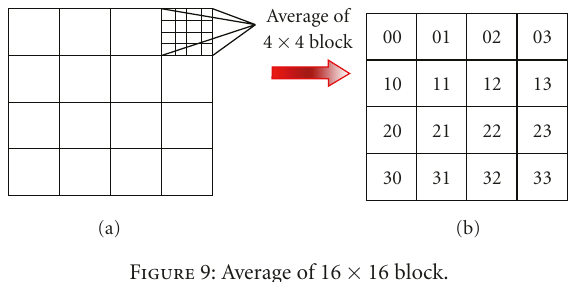
Figure 9: Average of 16 × 16 block.